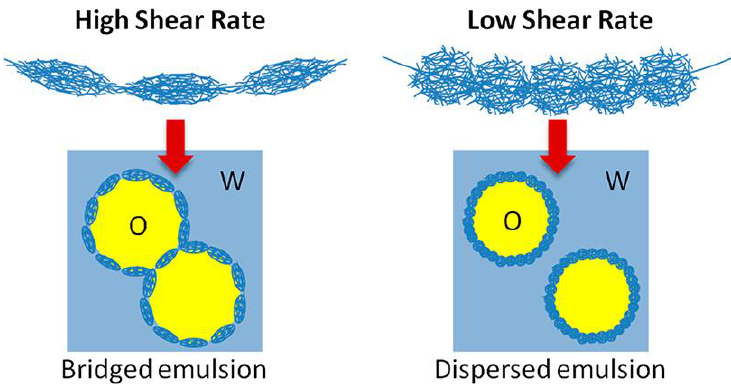
Figure 8. Effect of the shear rate on the dispersion of Mickering oil-in-water emulsions. Reprinted from Destribats et al. [79] with permission from the American Chemical Society, Copyright (2013).